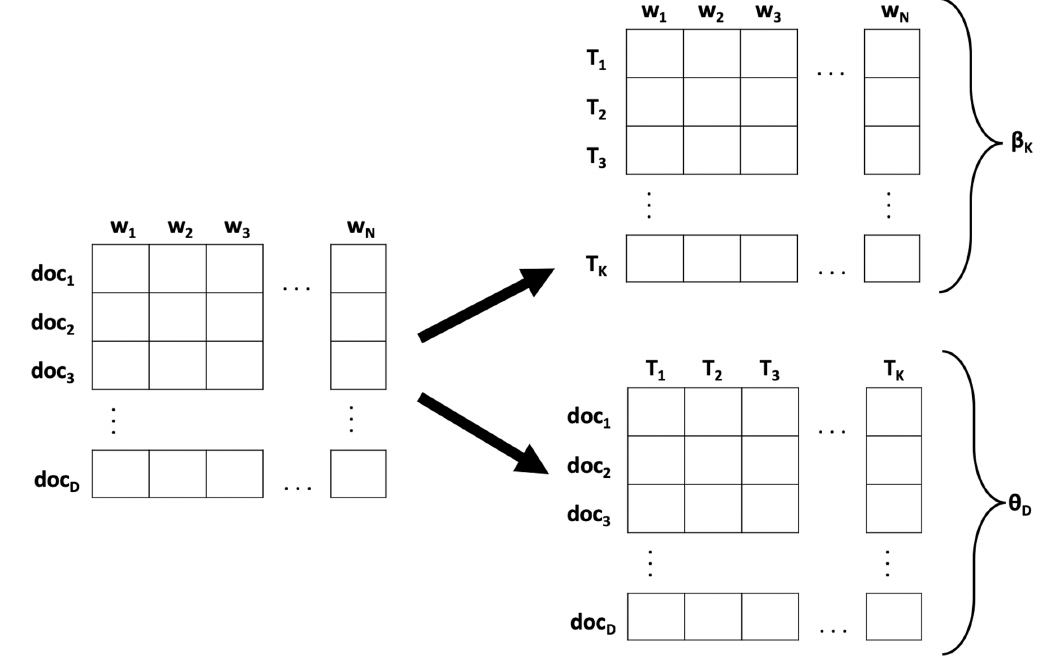
FIG. 2. Probabilistic matrix factorization interpretation of